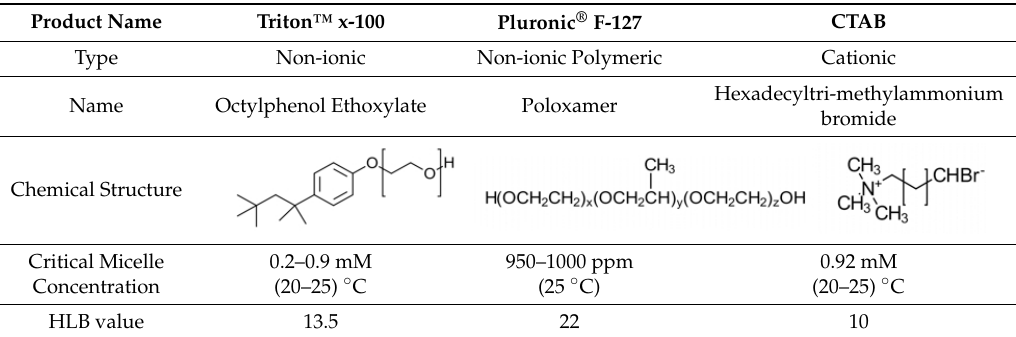
Table 1. Surfactants used in this study.